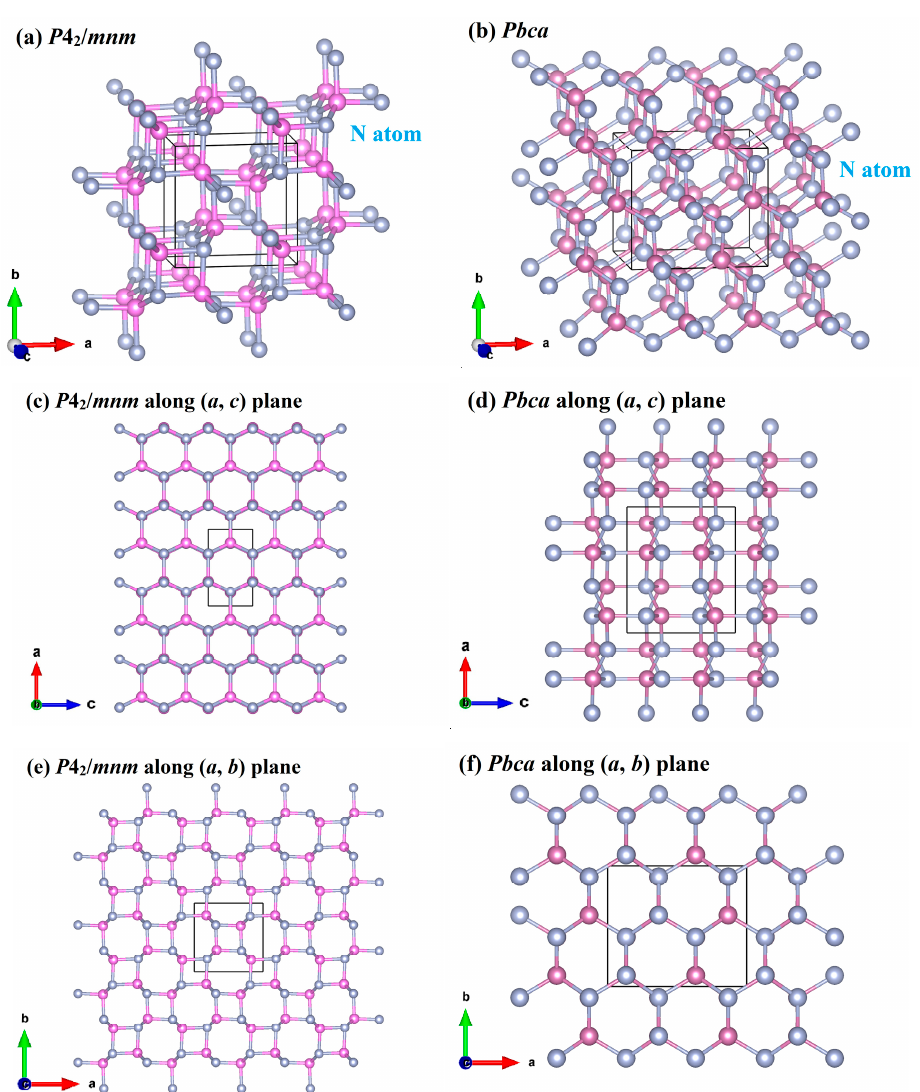
Figure 1. Crystal structure of XN in the P 4 2 / mnm phase ( a ) and the P 4 2 / mnm phase along the ac plane ( c ) and the ab plane ( e ); crystal structures of XN in the Pbca phase ( b ) and the Pbca phase along the ac plane ( d ) and the ab plane ( f ).